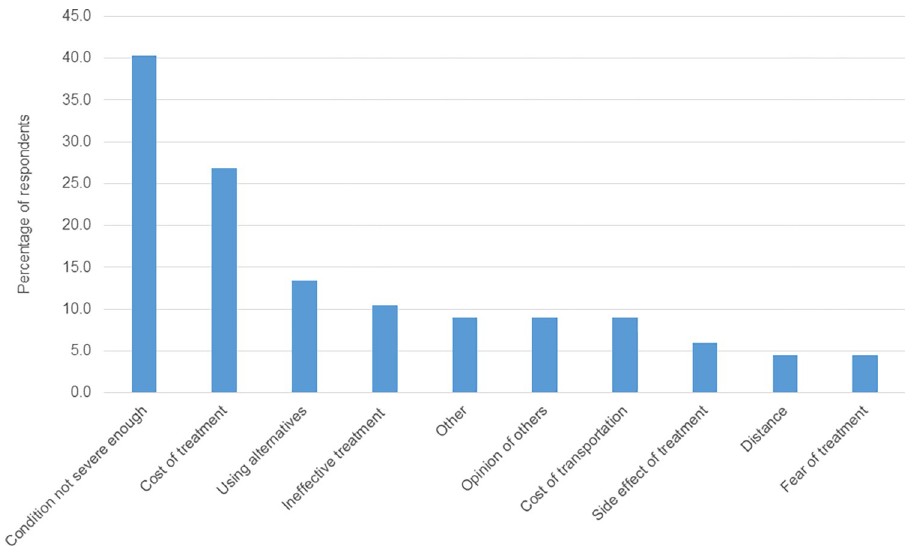
Fig 3. Reasons for delayed care seeking among scabies group (community setting and dermatology clinic). � Other reasons for delayed care seeking included pregnancy (1), lack of awareness about cause of disease (2), expired health insurance (1), busy work schedule (1) and absence of health facilities in community. https://doi.org/10.1371/journal.pntd.0011175.g003 (40.5% versus 13.3%, p = 0.001), positive opinion of others (56.8% versus 30.0%, p = 0.001) than those recruited from the community. Additional reasons for seeking formal healthcare included positive experiences of previous patients and failed earlier treatments. Only 6/67 con- sidered proximity to health centre as an important factor when making decisions. Only one person indicated the traditional healer as the preferred health care provider. The one person who visited a traditional health spent 30 Ghana cedis (~$3). Patients who visited a doctor or nurse spent a median of 20 Ghana cedis on the treatment (IQR 17.5–50). Data on the cost of transportation to seek care was not collected.